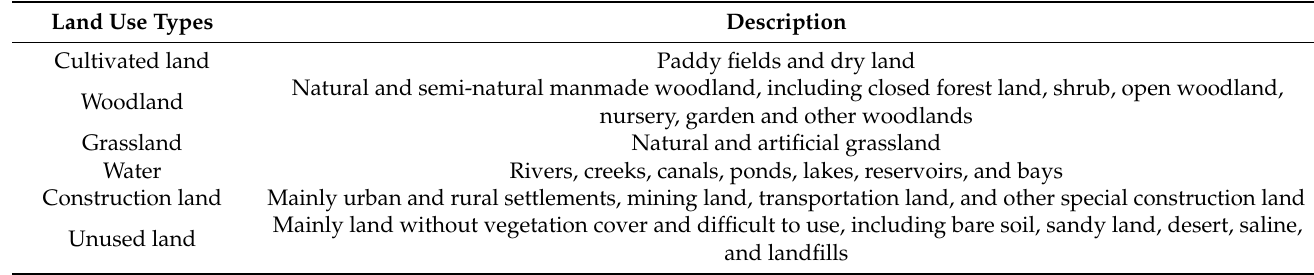
Table 2. Description of land use types in the Yellow River Basin (Henan section).